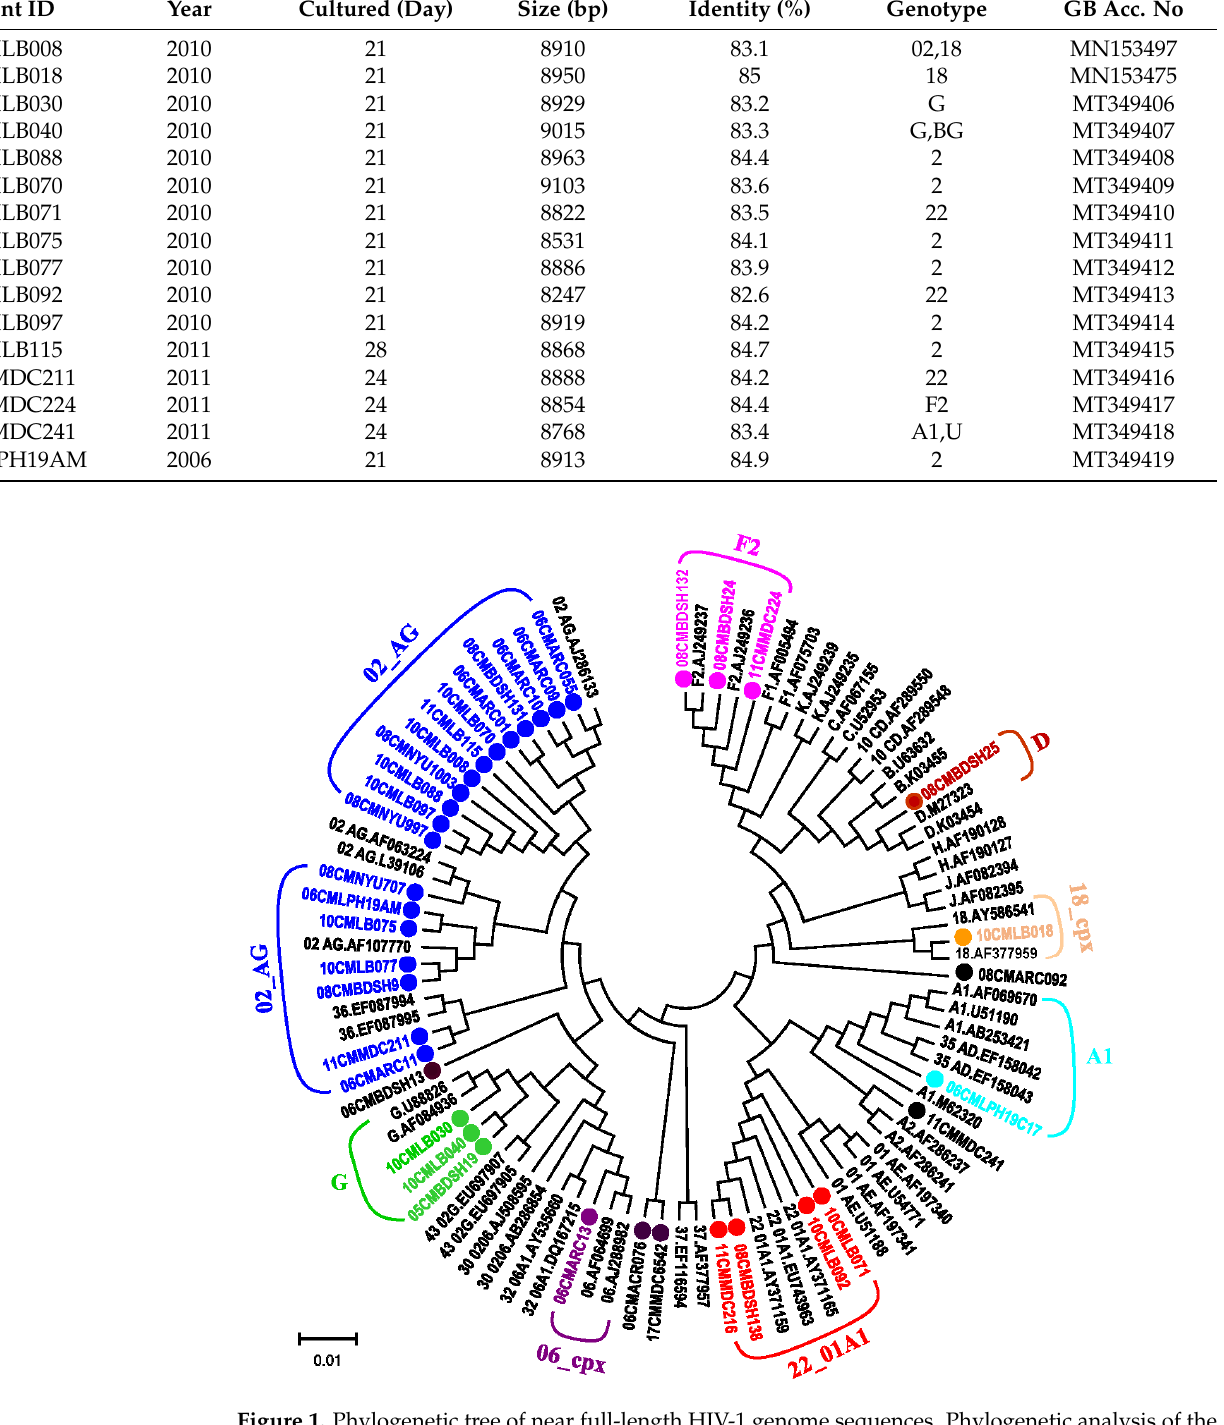
Figure 1. Phylogenetic tree of near full-length HIV-1 genome sequences. Phylogenetic analysis of the near full-length genome sequence was performed using the neighbor-joining module with Kimura’s two-parameter method and bootstrap analysis (1000 replicates); the bootstrap values above 70% are used. The reference sequences of subtypes and CRFs indicated as black were obtained from Los Alamos National Labs (LANL) HIV sequence database (www.hiv.lanl.gov, accessed on 29 April 2021) to construct the tree. Some reference sequences have been omitted for clarity. The new identified isolate sequences are color coded and indicated as dots “•”.